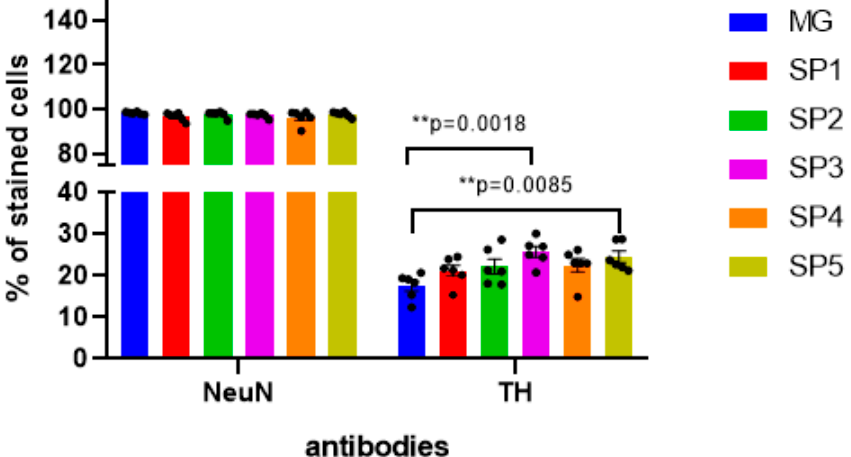
Figure 7. Immunocytochemical staining of DNs obtained by the cultivation of NPC on CCs and MG with antibodies against tyrosine hydroxylase (TH) and the common neuronal marker NeuN. Individual repeat values in the histogram are indicated by black dots. Mean ± SEM, N = 6. One-way ANOVA followed by Dunnett’s post hoc test. ** p ≤ 0.01 compared with MG.